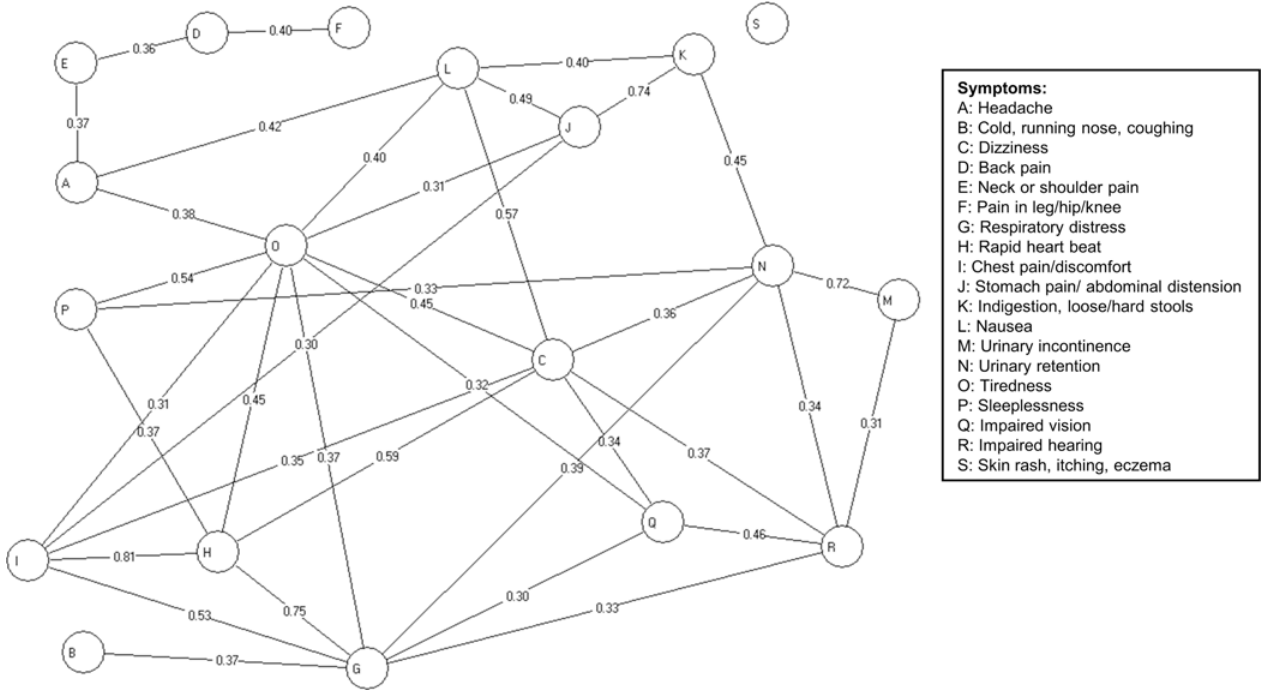
Fig 2. Chain graph model showing the associations between symptoms. All lines represent significant conditional associations. The numbers indicate the partial γ -coefficients. To reduce the complexity of the figure, only strong associations, i.e. γ > 0.30, are shown, while associations with 0.10 < γ < 0.30 are included in the statistical model but not in the figure. The associations are adjusted for age and sex (not shown in the